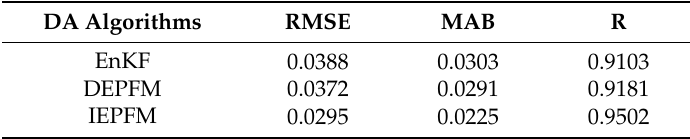
Table 2. Comparison of the performance of three DA